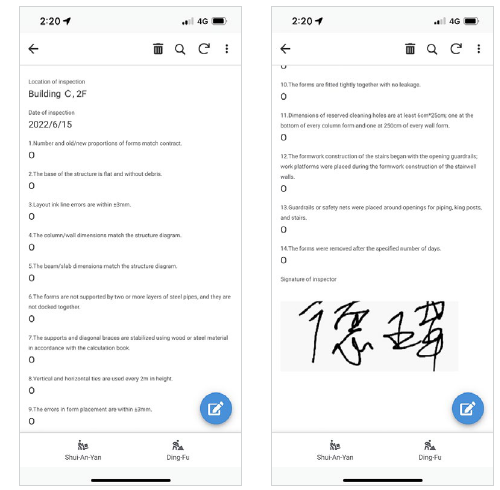
Figure 31. Second set of inspection